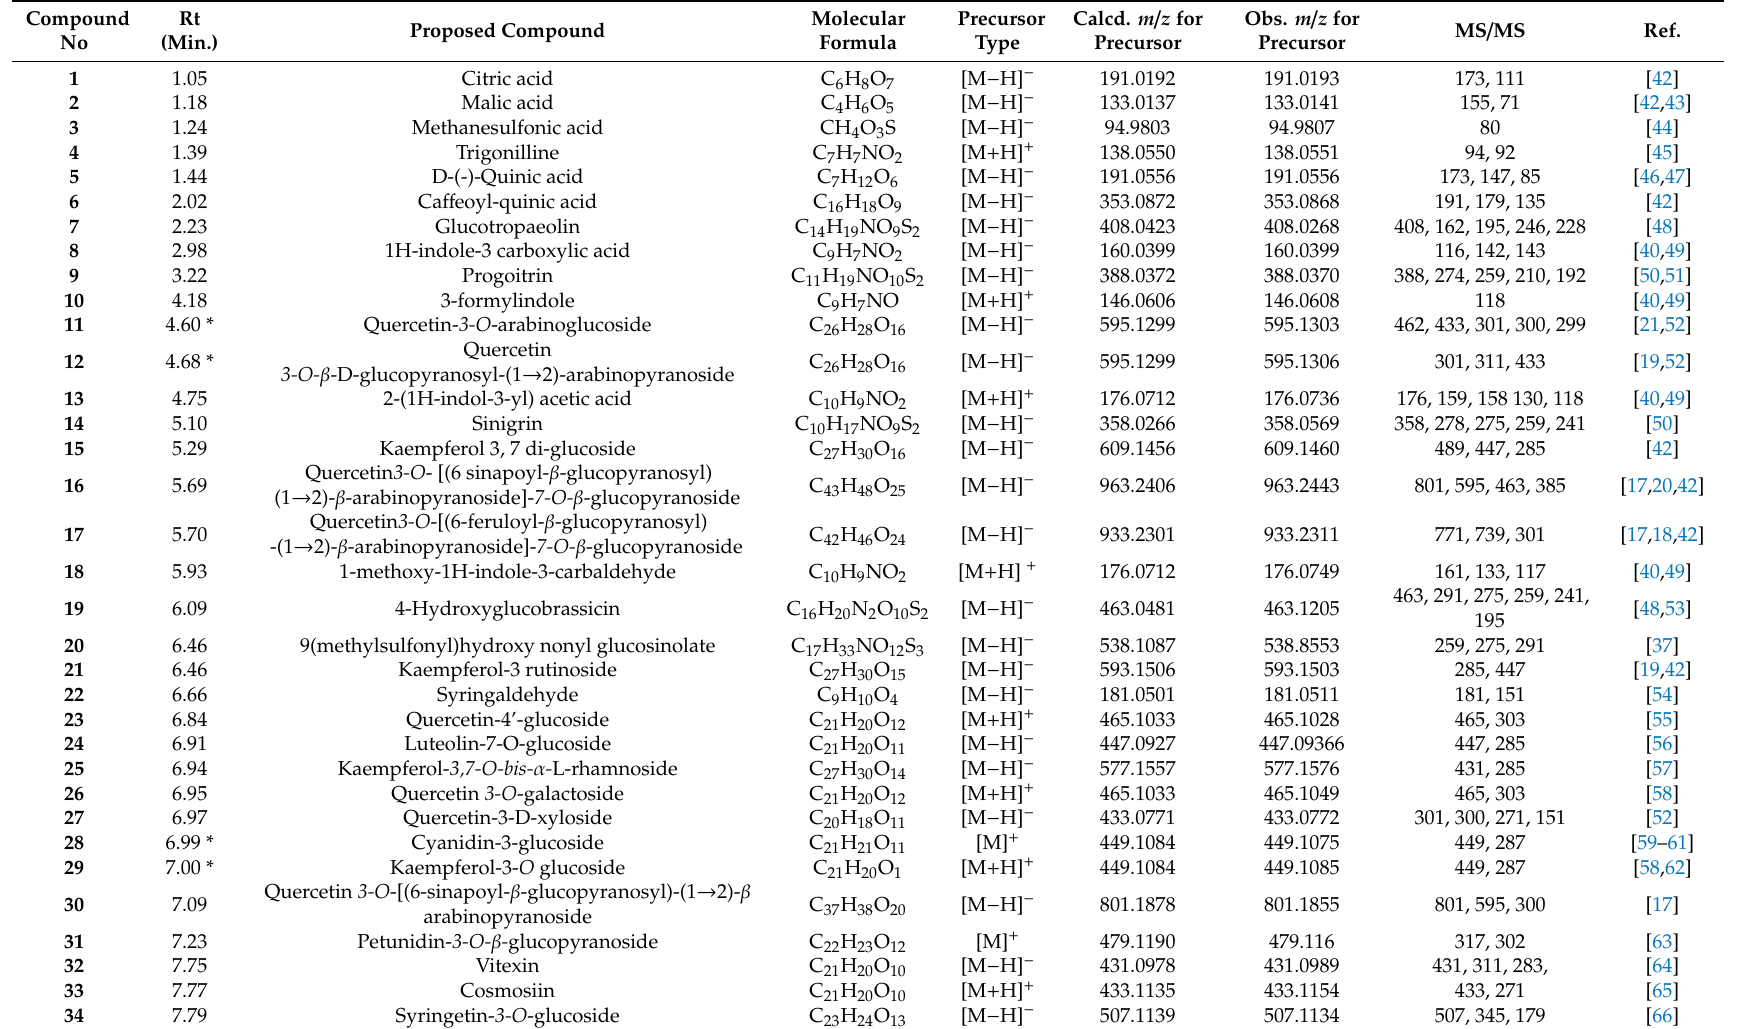
Table 2. Metabolites identified in C. annua crude extract using LC-ESI / TOF / MS /